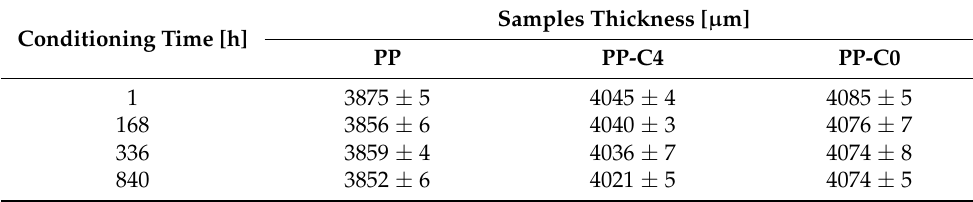
Table 4. Thickness of conditioned PP